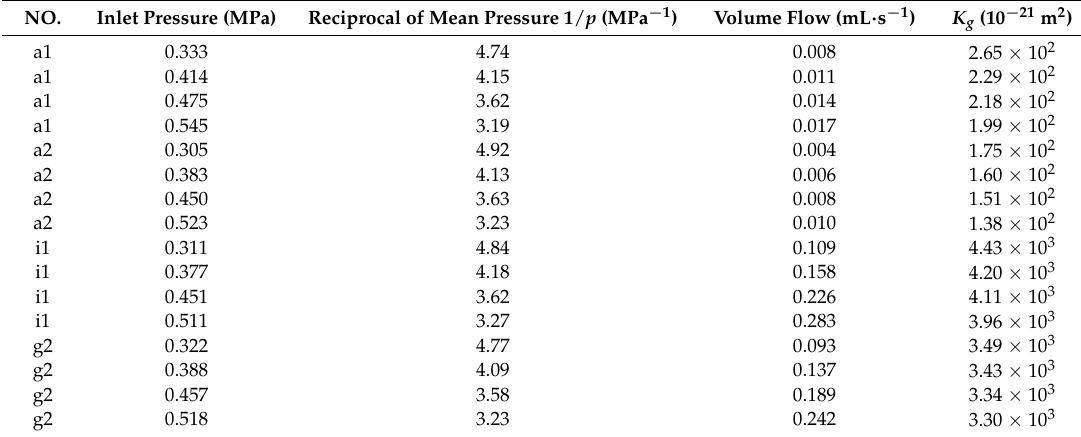
Table 5. Permeability test results.